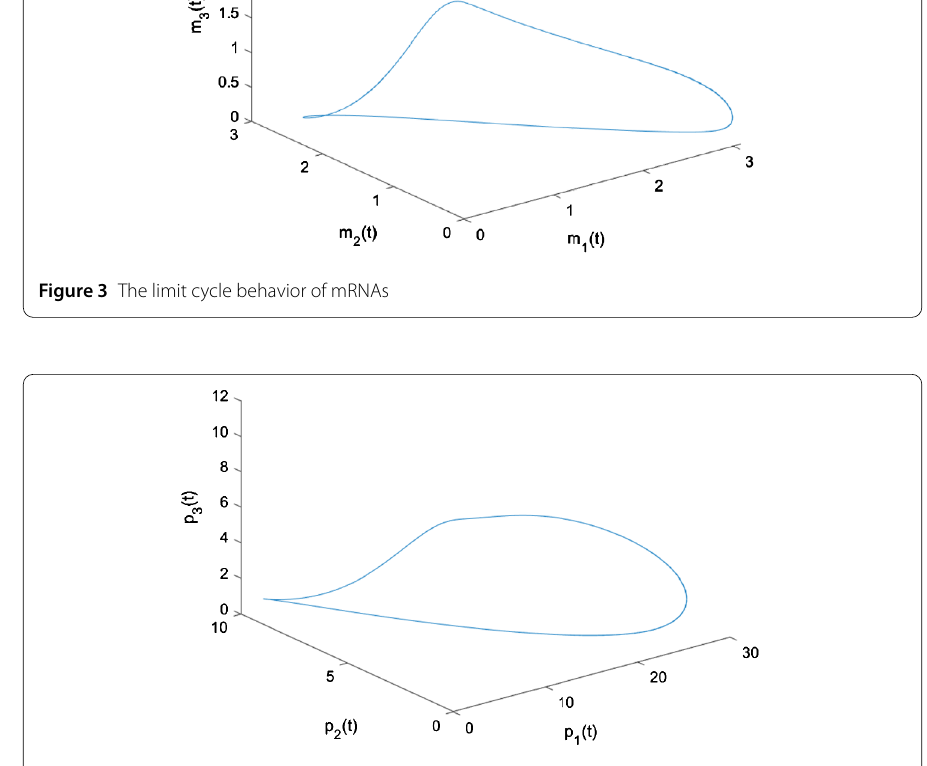
Figure 4 The limit cycle behavior of